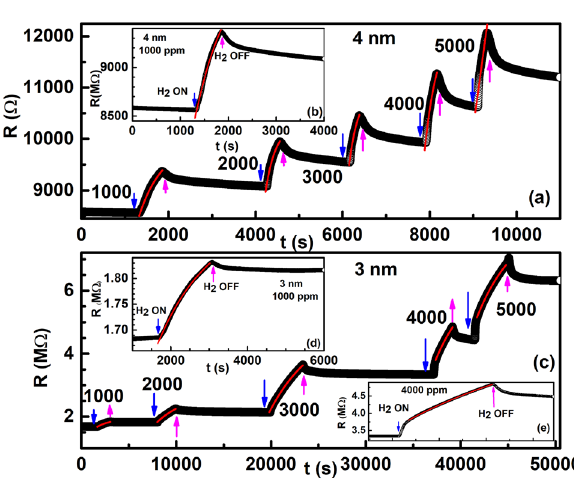
Figure 12. Main panel of ( a ) and ( c ) show the time dependence of resistivity in ultra-thin films of thickness ( a ) 4 nm and ( c ) 3 nm on exposure to hydrogen of varying concentrations. Insets ( b ) and ( d ) show an exponential fit (see text for details) on an expanded scale for clarity at a hydrogen loading of 1000 ppm. Inset ( e ) shows a straight line fit to the data at 4000 ppm H 2